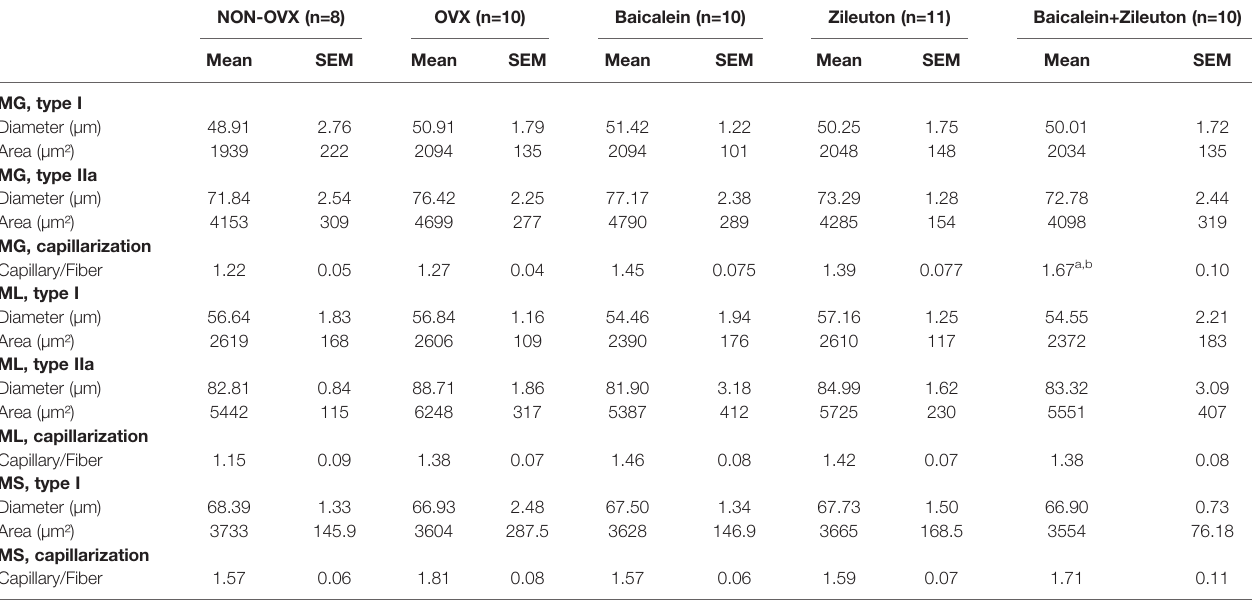
TABLE 4 | Histological analyses of M. Gastrocnemius (MG), M. Longissimus (ML) and M. Soleus (MS). NON-OVX (n=8) OVX